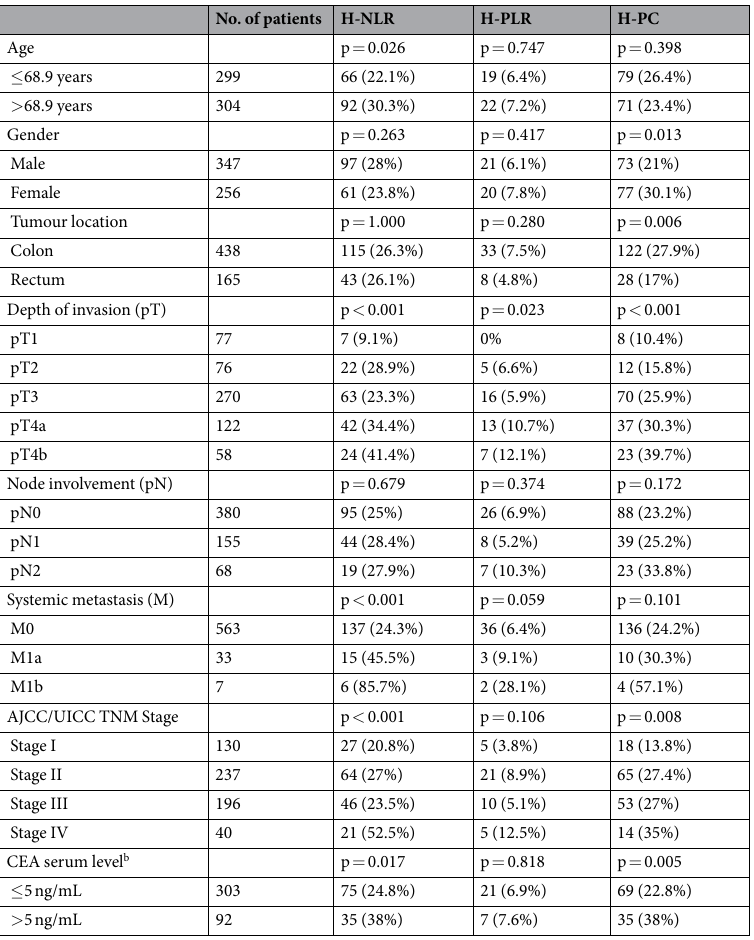
Table 2. Correlations between NLR, PLR and PC and main clinicopathological variables for the 603 patients under